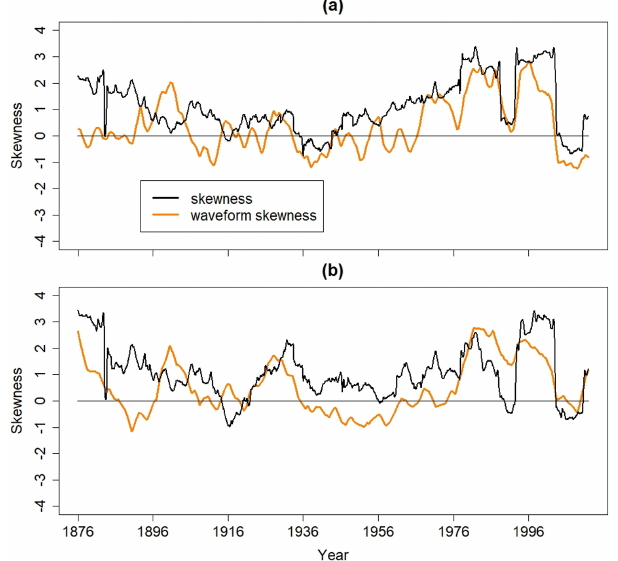
Figure 7. 20-year sliding skewness and waveform skewness time series corresponding to the (a) Niño 1 + 2 and (b) Niño 3